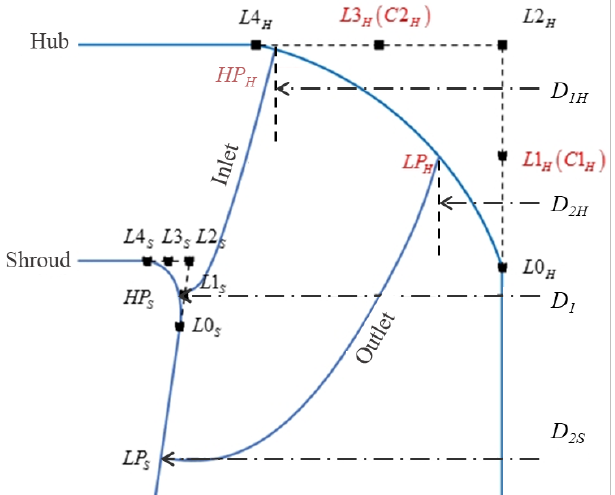
Figure 5. Meridional channel parameterization.